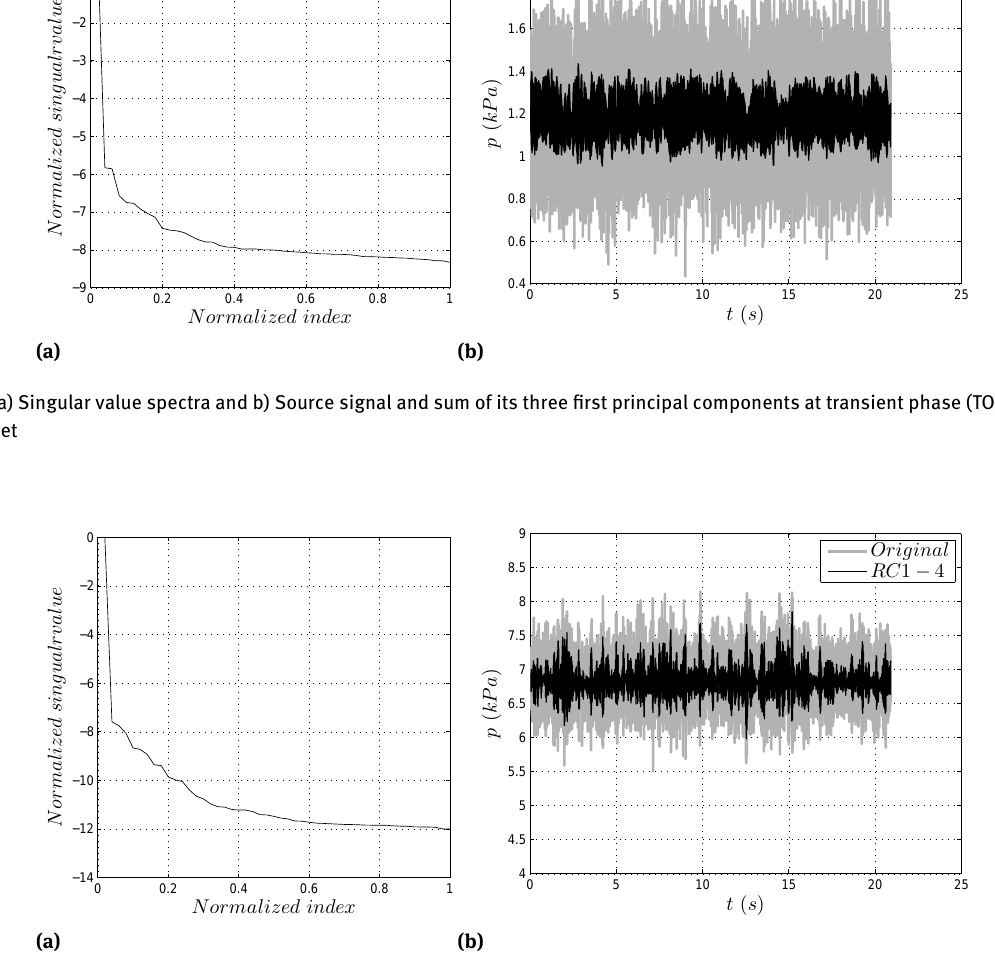
Figure 9: a) Singular value spectra and b) Source signal and sum of its three first principal components at transient phase (TOA = 10%) at the blower